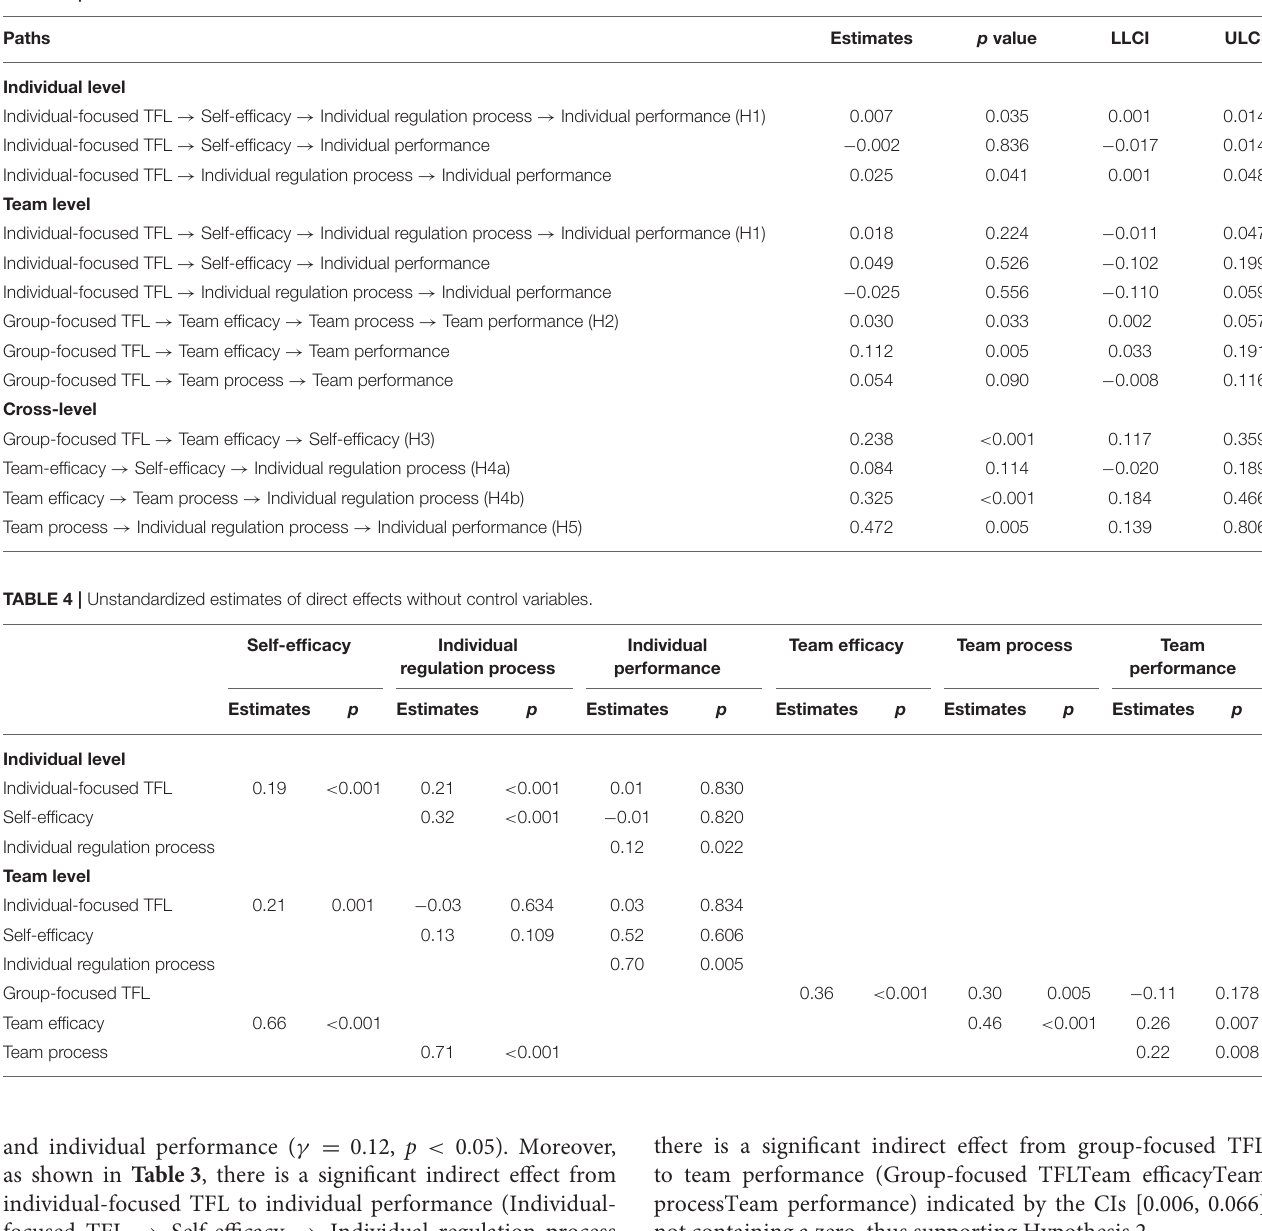
TABLE 3 | Unstandardized estimates of indirect effects.